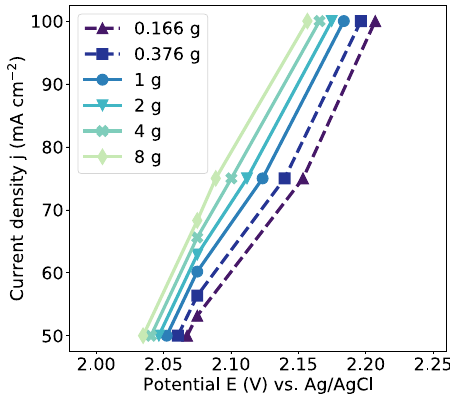
Fig. 8 Relationship between potential difference and current density. The current density as a function of potential based on the trends identi fi ed for this electrochemical system. Solid lines represent hypergravity data and dashed lines represent reduced-gravity data collected both galvanostatically and potentiostatically. Source data are provided as a source data fi